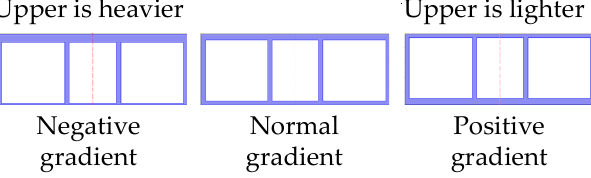
Figure 24. The OBSs with varying density gradients.